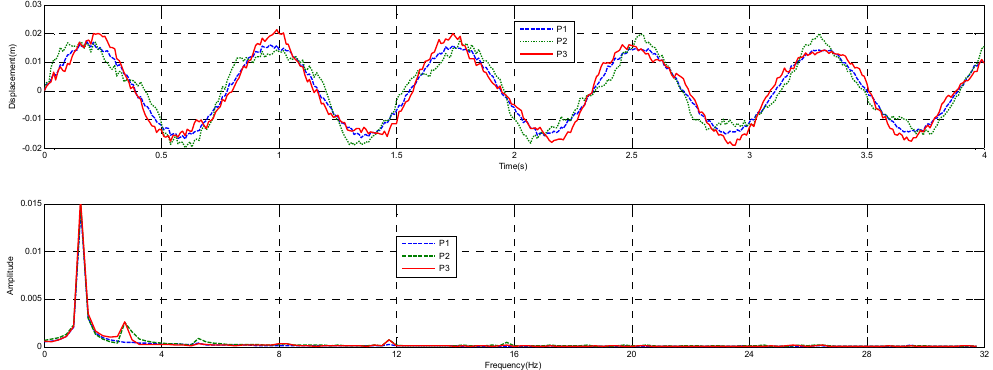
Figure 23. The plot of x-displacement vs. time when the thickness is 0.03 m, P22.